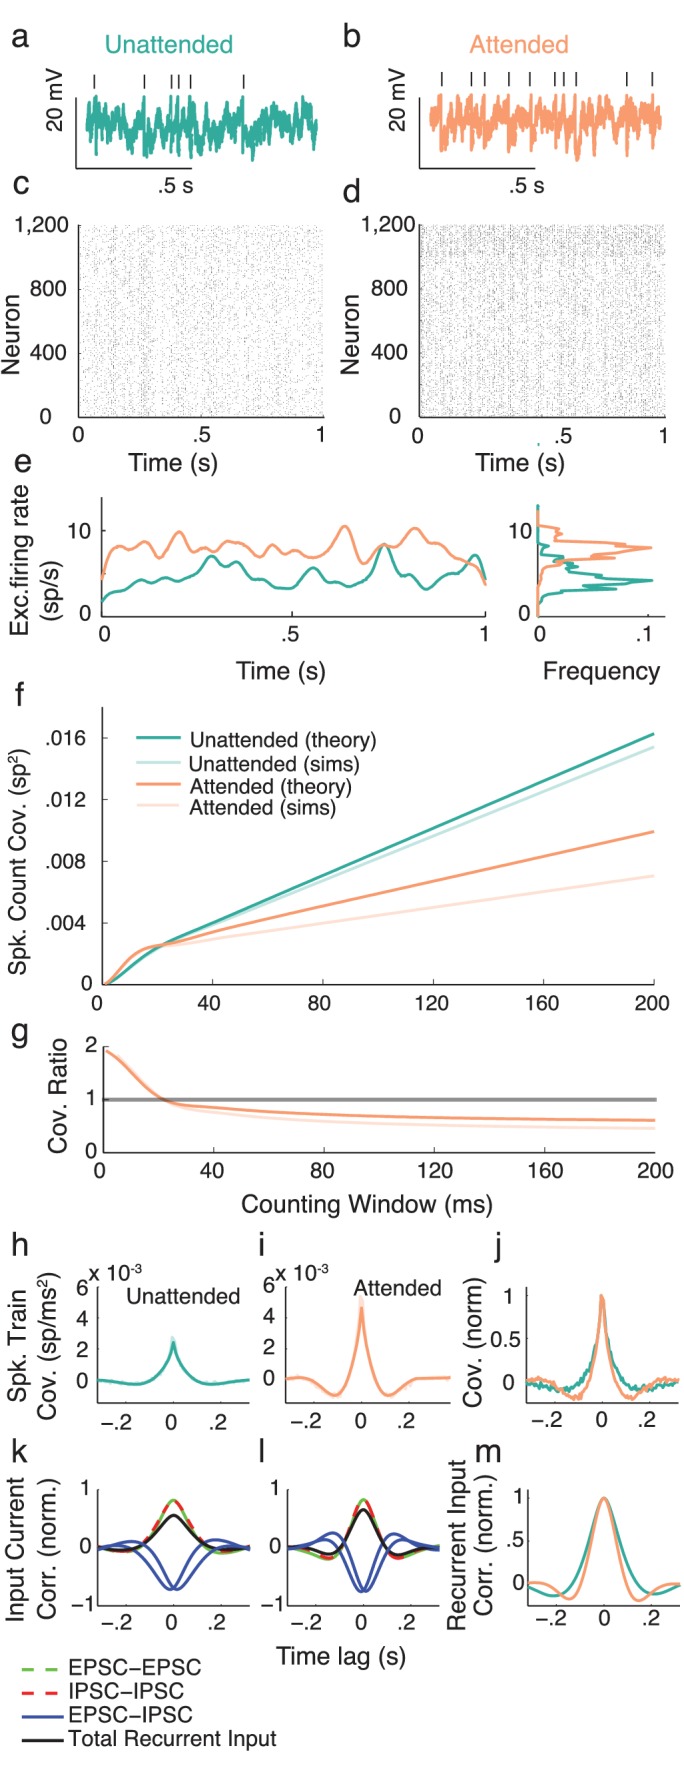
Spiking model and simulations.(a,b) Example voltage trace from an excitatory model neuron in the unattended (a) and attended (b) states. Top tick marks denote spike times. (c) Raster plot of neurons in the unattended state. Neurons 1 to 1000 are excitatory, and 1001 to 1200 are inhibitory. (d) Raster plot of neurons in the attended state. (e) Excitatory population-averaged firing rates for the unattended (turquoise) and attended (orange) states. Right: frequency distributions of population-averaged firing rates. (f) Mean pairwise spike count covariance for different counting windows. Other than an increase in synchrony on very small timescales due to gamma oscillations, the spike count covariance decreases with attention regardless of counting window. (g) Ratio RC⁢o⁢v of attended and unattended spike count covariance, as a function of counting window. (h, i) Derived (solid turquoise) and simulated (muted turquoise) spike train cross-covariance functions of excitatory neurons in the unattended (h) and attended (i) states, averaged over pairs. (j) Spike train cross-covariance functions of excitatory neurons in the unattended and attended states, normalized to peak at 1. (k, l) Normalized input current cross-correlation functions of excitatory inputs to pairs of neurons (dashed green), inhibitory inputs to pairs of neurons (dashed red), excitatory and inhibitory inputs to pairs of neurons (blue), and summed excitatory and inhibitory recurrent inputs to pairs of neurons (black), in the unattended (k) and attended (l) states. (m) Attended (orange) vs unattended (turquoise) recurrent input cross-correlation functions. The excitatory cross-correlation function is narrower, just as for the output cross-covariance function, so the effects are happening on the level of inputs.